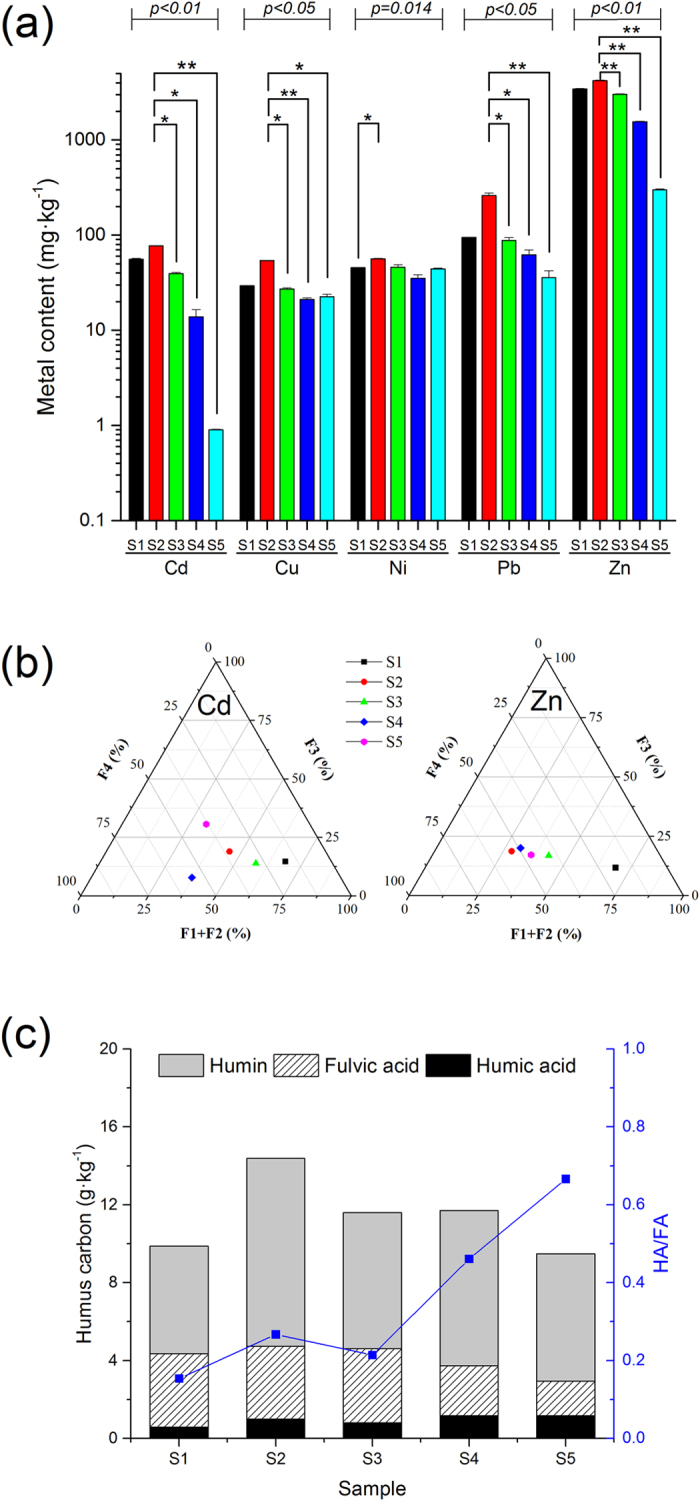
Total heavy metals, available heavy metals (Cd and Zn) and soil organic fractions in all five soil samples of zinc smelter.(a) Total heavy metals and grouped column chart with Y axis expressed as log 10 illustrates the heavy metals contents data collected for five different samples. This graph shows use of the “asterisk bracket” object for indicating significant differences between samples. (b) Triangular diagrams showing heavy metal (Cd and Zn) speciation in different soils. F1-acid soluble, F2-reducible, F3-oxidizable, F4-residual. (c) Humus carbon composition, humic acid and fulvic acid index in different soil samples.